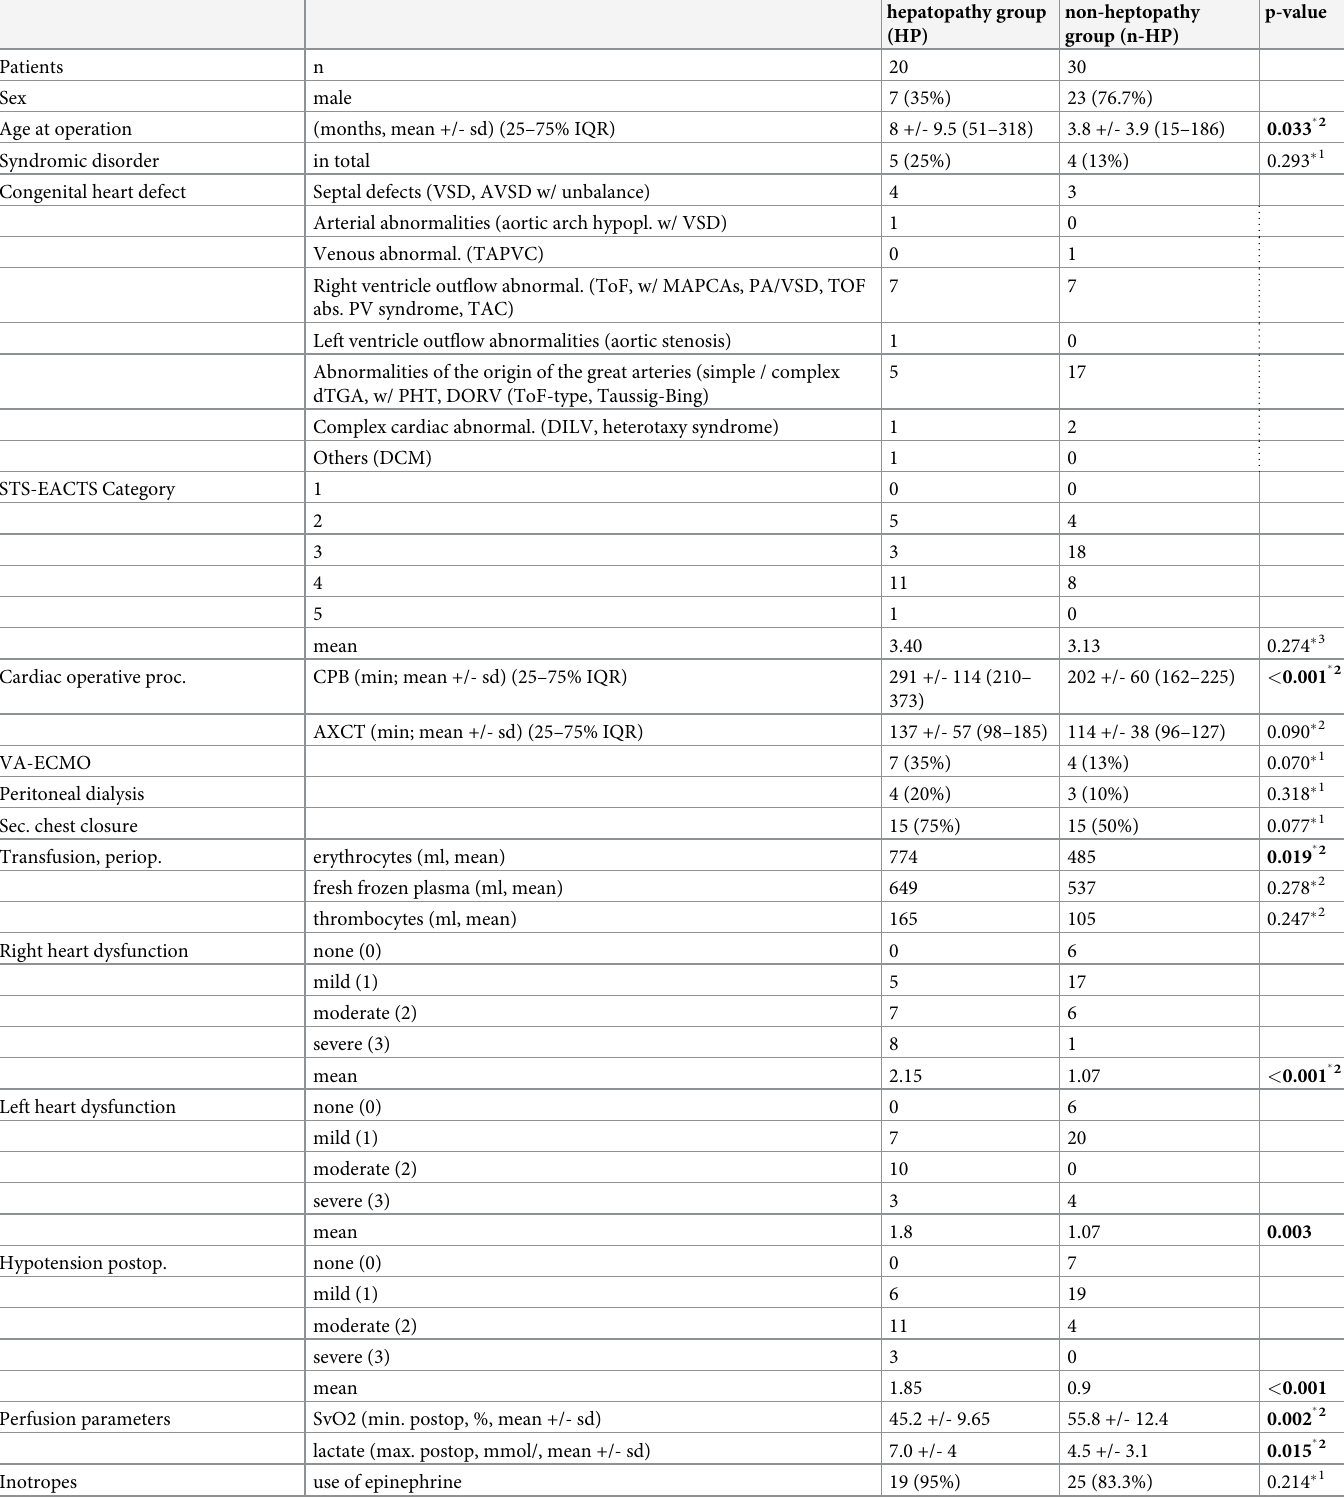
Table 1. Demographic and perioperative